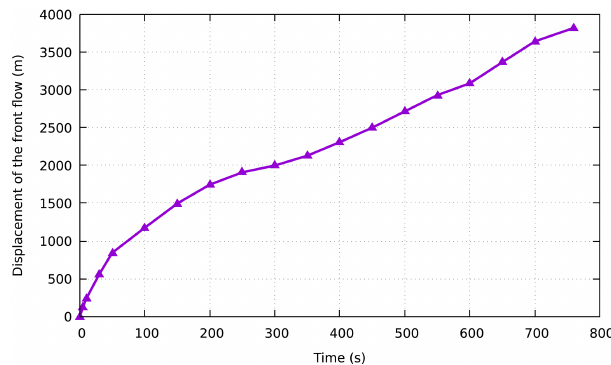
Figure 14. Displacement time history for the front flow of A’xi fail- ure in the